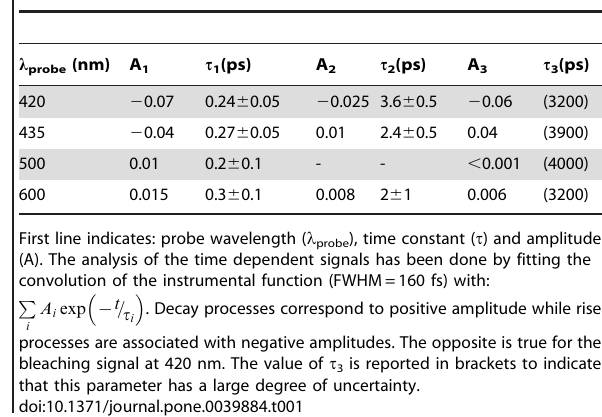
Table 1. Multiexponential fit of the observed kinetic profiles shown in Fig. 2 recorded in the Tf -trHb-CO complex.